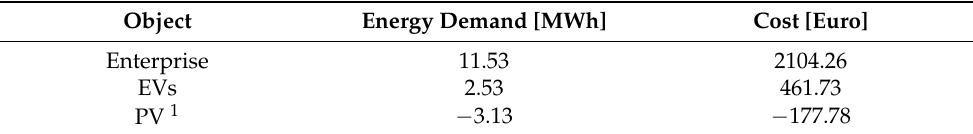
Table 5. Summary of energy consumption for the company and the vehicle fleet for model III.